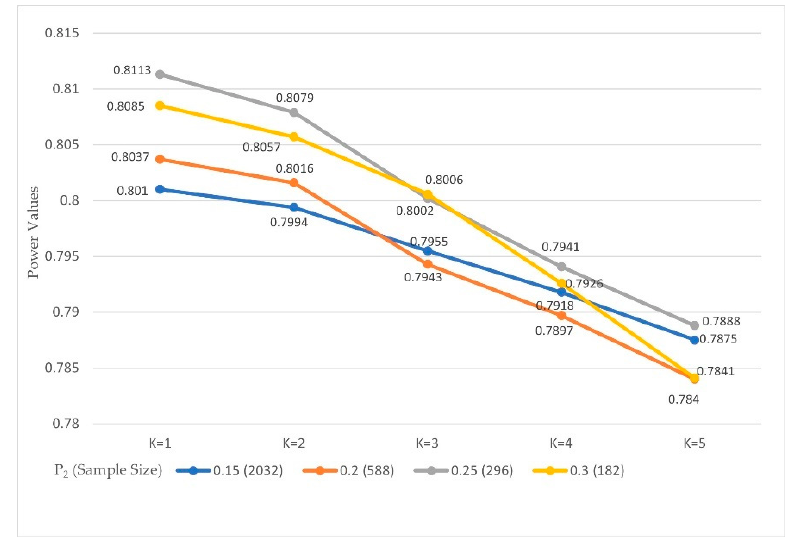
Figure 5. Power values for OWMP with α = 0.01, P 1 = 0.1, and P 2 = 0.15, 0.2, 0.25, 0.3. The probability value P 1 = 0.1 was fixed, and the power rates with various values for P 2 = 0.15, 0.2, 0.25, and 0.3, were studied. The sample sizes 1366, 396, 200, and 120 for α = 0.05, and 2032, 588, 292, and 182 for α = 0.01 were used to ensure that the power values were 0.8.